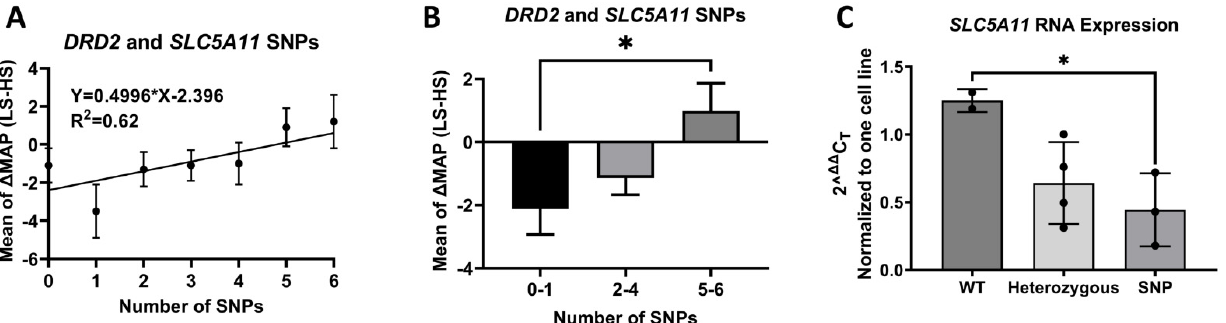
Figure 8. Solute Carrier Family 5 Member 11 (SLC5A11) and DRD2 SNPs. ( A ) There is a linear relationship between the number of SNPs in DRD2 (rs6276 and rs6277) and SLC5A11 (rs11074656) and the magnitude of change in MAP ( ∆ MAP) when transitioning between a high and low salt diet (Y = 0.4996X − 2.396, R 2 = 0.62, p < 0.05). ( B ) The cohort was divided into 3 groups, those with 1 or less, those with 2 to 4 and those with 5–6 DRD2 and SLC5A11 SNPs. ∆ MAP is significantly greater in those with 5–6 SNPs than those with 1 or no SNPs (0–1: − 2.12 ± 0.81, n = 58; 2–4: − 1.14 ± 0.52, n = 190; 5–6: 0.98 ± 0.88, n = 54, * p < 0.05, one-way ANOVA, Tukey’s test). ( C ) Real time RT-PCR shows a significantly lower SLC5A11 expression in cell lines with SNPs than in cell lines with no SNPs, i.e., wild-type (WT) cell lines (WT, 1.25 ± 0.06, n = 2; heterozygous, 0.64 ± 0.15, n = 4; SNP, 0.44 ± 0.16, n = 3; WT vs. SNP, * p < 0.05, one-way ANOVA, Tukey’s test). Table 1. Distribution of SLC5A11 rare variant, rs11074656, in different salt sensitivities. Salt Sensitivity WT Heterozygous SNP ISS 9 (29%) 19 (61%) 3 (10%) SR 111 (51%) 83 (38%) 24 (11%) SS 20 (38%) 23 (43%) 10 (19%) Χ 2 = 9.77 p < 0.05.